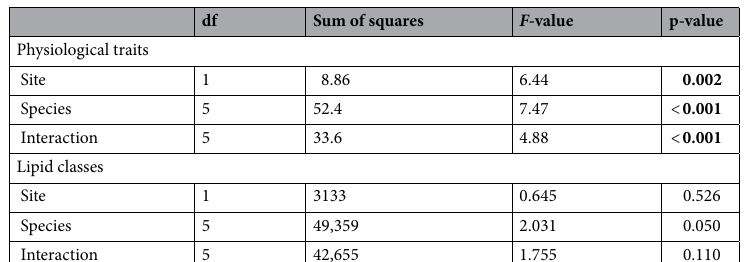
Table 3. PERMANOVA p-values for the effect of physiological traits (AFDW, total lipid, soluble protein, and carbohydrate) and lipid class composition (WAX, TAG, ST, and phospholipids). Site and species are used as the constraining variables. Significant p-values (p < 0.05) are in bold.